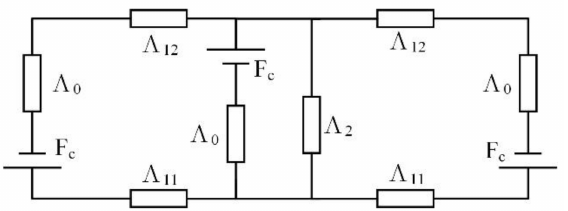
Figure 5. The equivalent synthetical magnetic circuit of two